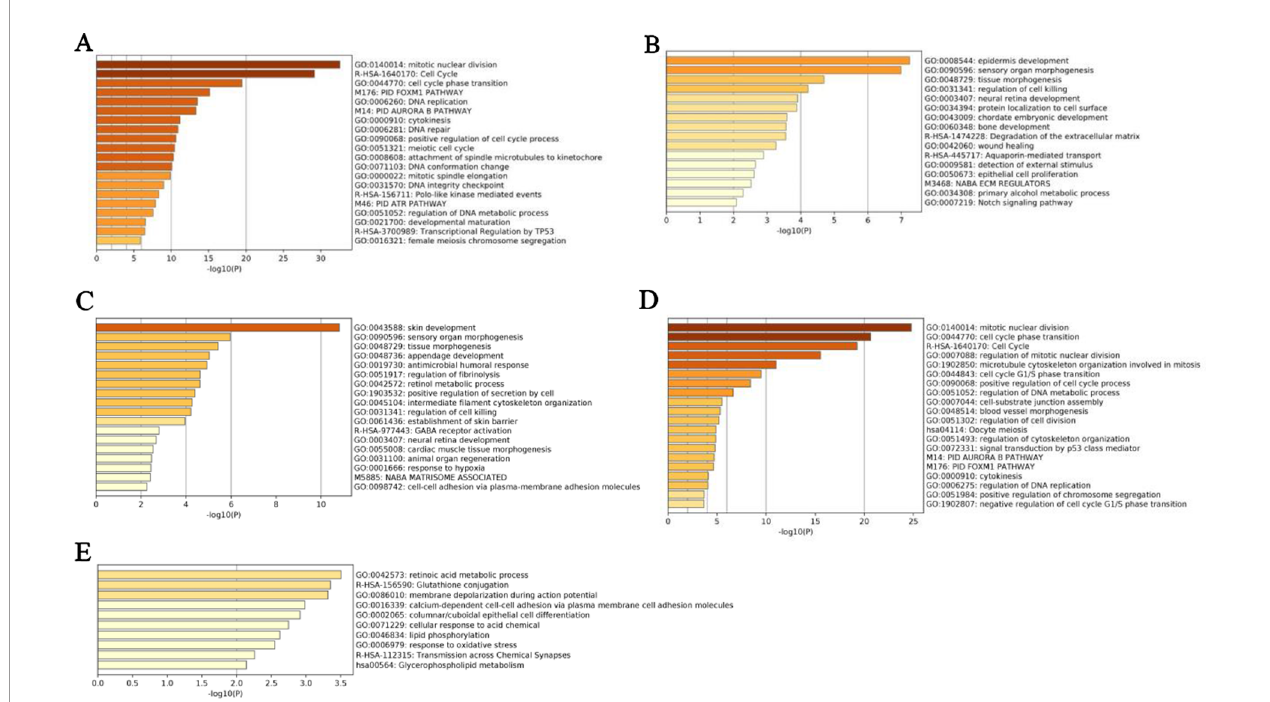
FIGURE 7 | Enrichment analyses of pathways and biological processes by top 100 genes selected by fi ve methods for lung squamous cell carcinoma (LUSC) dataset. (A) t -test, (B) edgeR, (C) DEseq2, (D) maximal information coef fi cient (MIC), (E) normalized differential correlation